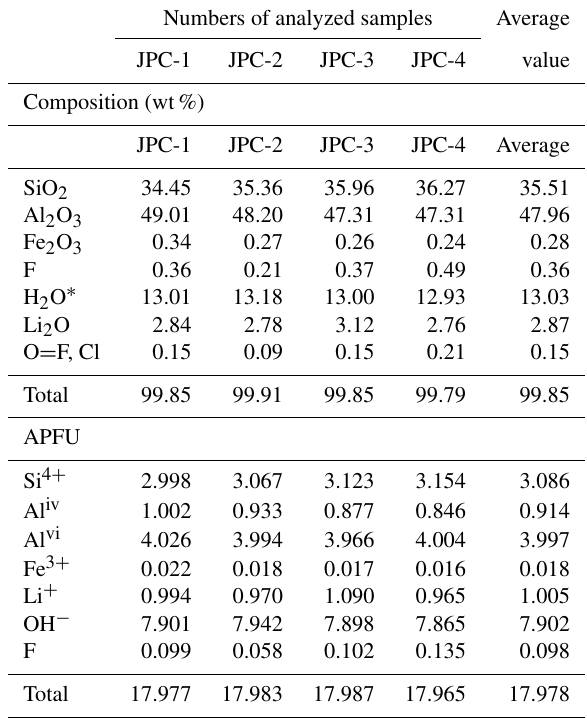
Table 1. Compositions of representative hydrous solid phases in the CIs from the Jiajika pegmatite analyzed by EMP and calculated us- ing the chemical formula of